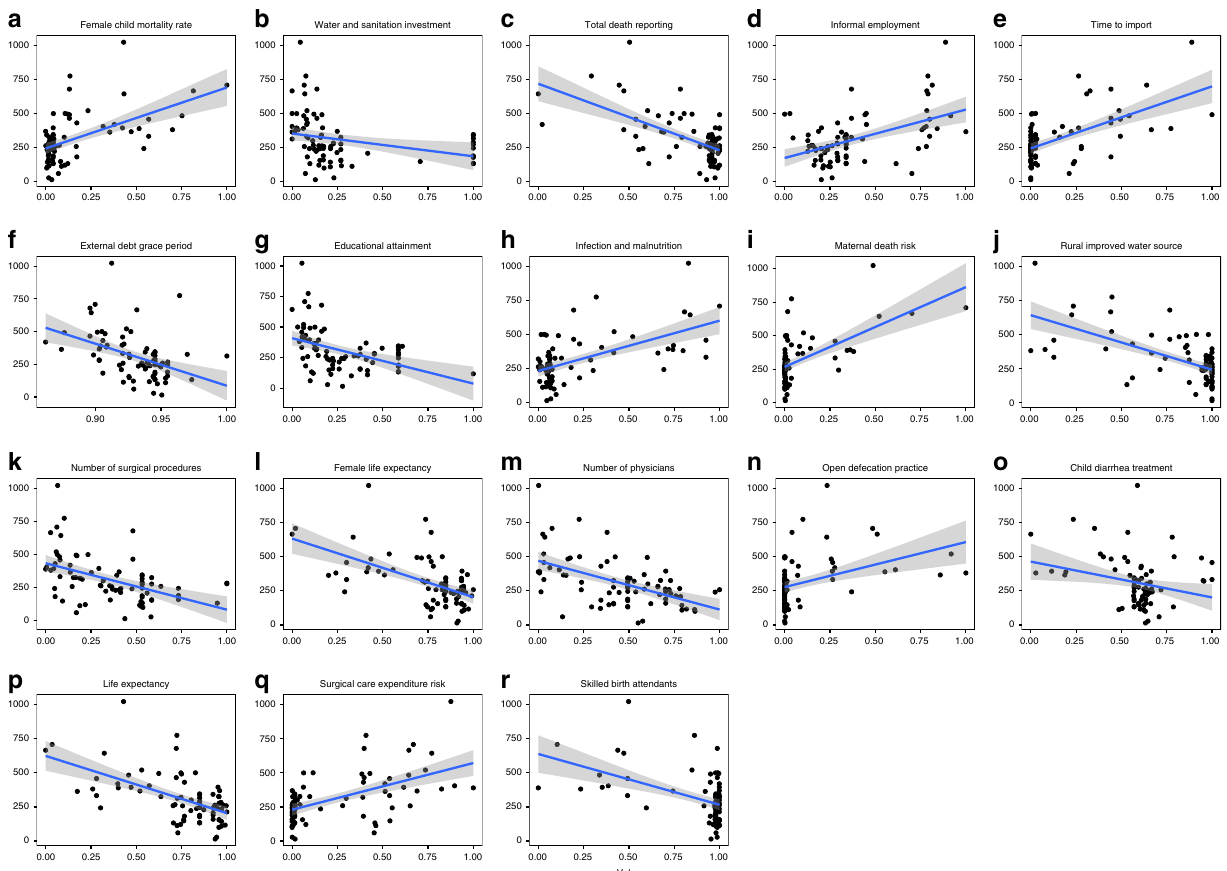
Fig. 3 World Bank variables signi fi cantly associated with the observed antimicrobial resistance abundances. Detailed information concerning the variables in a – r are presented in the same order in Supplementary Table 3